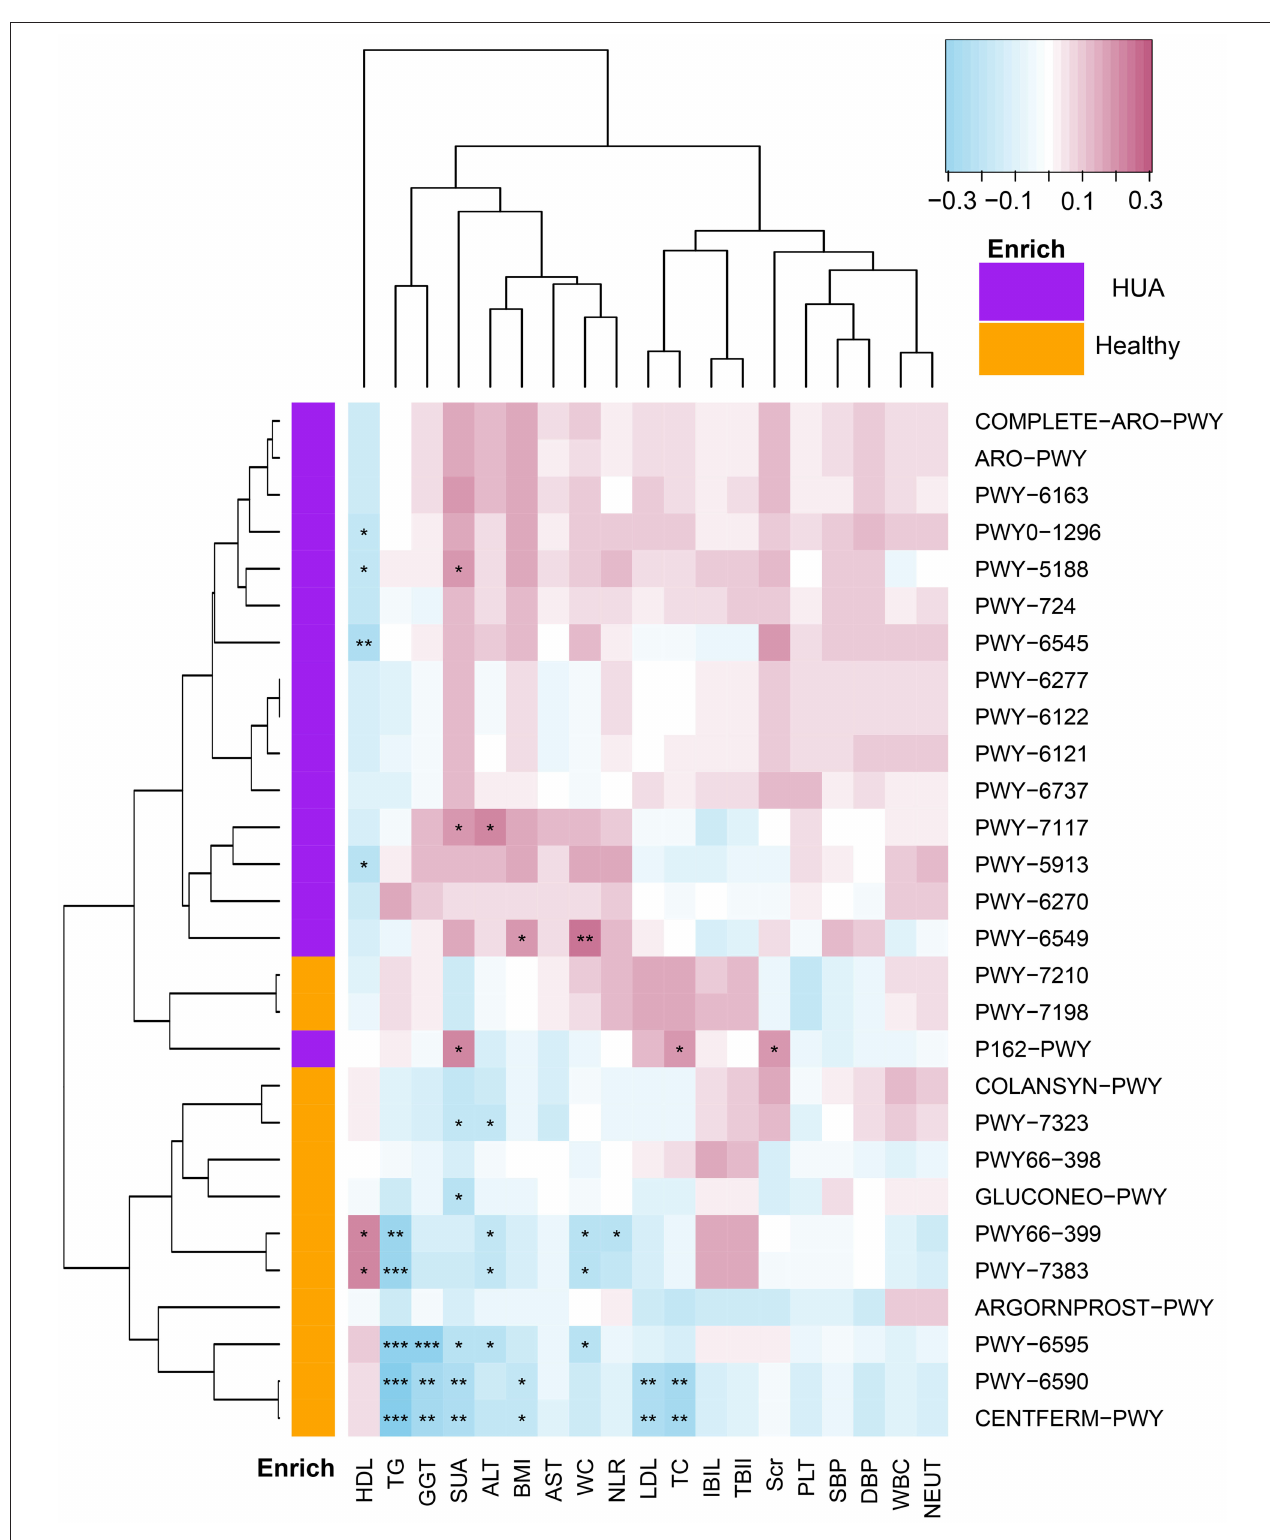
FIGURE 4 | Spearman’s correlation matrix for HUA group and healthy controls correlated pathways and clinical characteristics. Different cell color represented for relative correlation type (purple: negative, red: positive). Cells with *, **, or *** asterisk represented P < 0.05, 0.01, or 0.001 respectively.